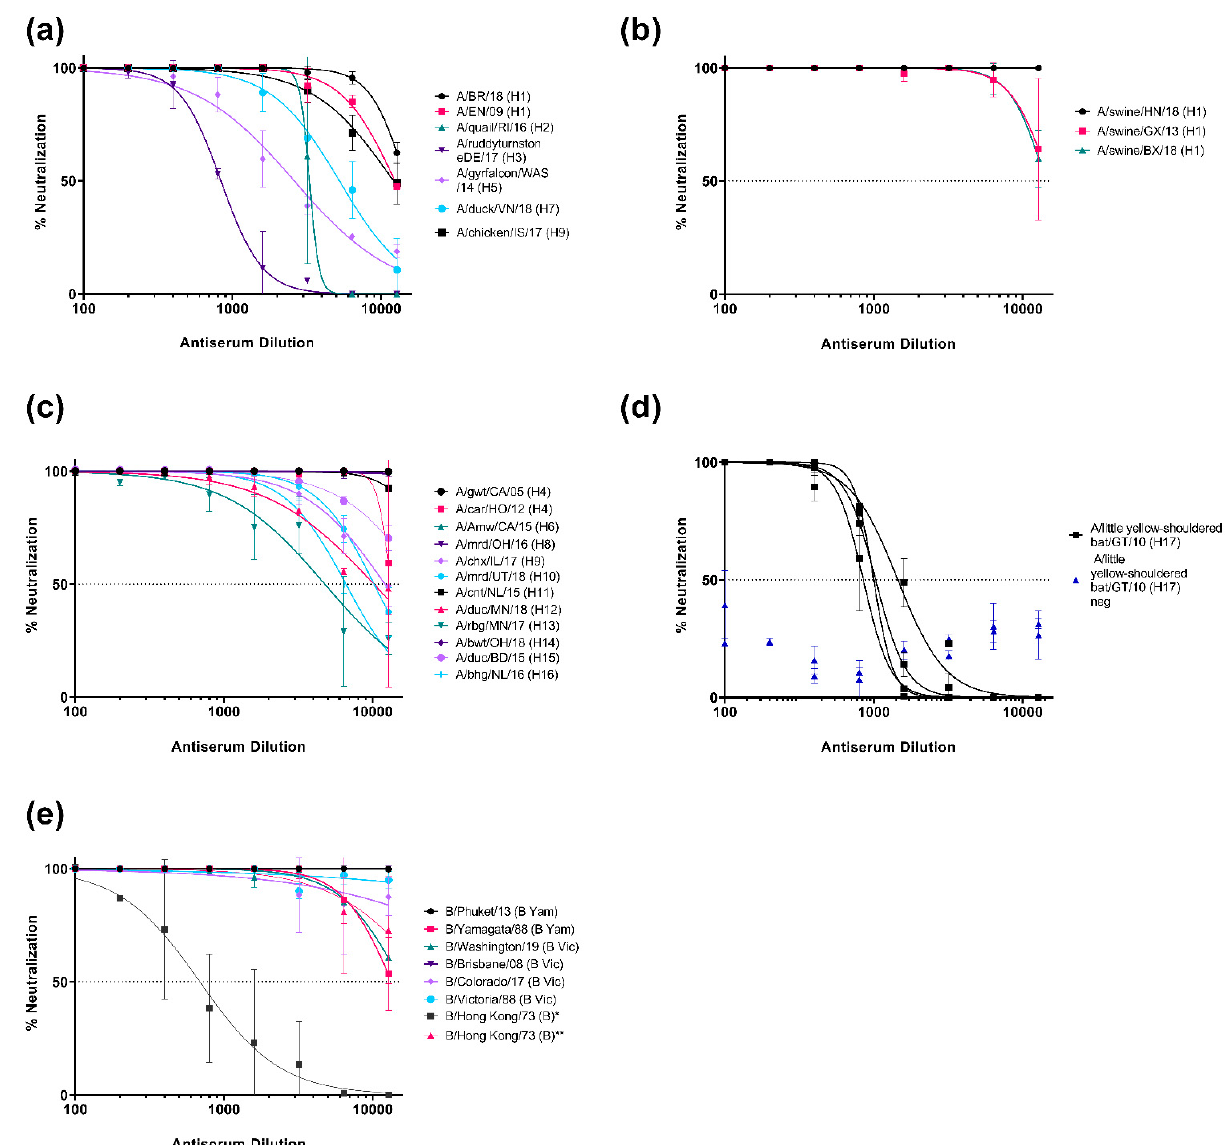
Figure 5. Neutralization of influenza pseudotypes by reference antisera and bat sera from influenza surveillance. ( a ) Neu- tralization of representative IAV subtypes that have previously caused infection in humans (H1, H2, H3, H5, H7, and H9). ( b ) Neutralization of pseudotypes representing IAV isolated from swine (H1). ( c ) Neutralization of pseudotypes that are representative of IAV found in avian populations (H4, H6, H8, H9, H10, H11, H12, H13, H14, H15, and H16). ( d ) Neutralization of H17 PV (A/little yellow-shouldered bat/Guatemala/060/2010) by bat sera from bat surveillance sampling in Nigeria as provided by APHA. ( e ) Neutralization of IBV pseudotypes that have caused human infection (B/Yamagata-like and B/Victoria-like viruses and presplit IBV). As presplit antiserum was not available, neutralization susceptibility of this PV to B/Yamagata lineage antisera (denoted with *) and B/Victoria lineage antisera denoted with **) have been shown. Neutralization was measured by a luciferase reporter assay. Reference antisera and bat sera were serially diluted two-fold from a starting dilution of 1:100. A total of 1.0 × 10 6 RLU of PV was then added to each well. For all plots, each point represents the mean and standard deviation of two replicates per dilution. Details of reference antisera are indicated in Table 2.